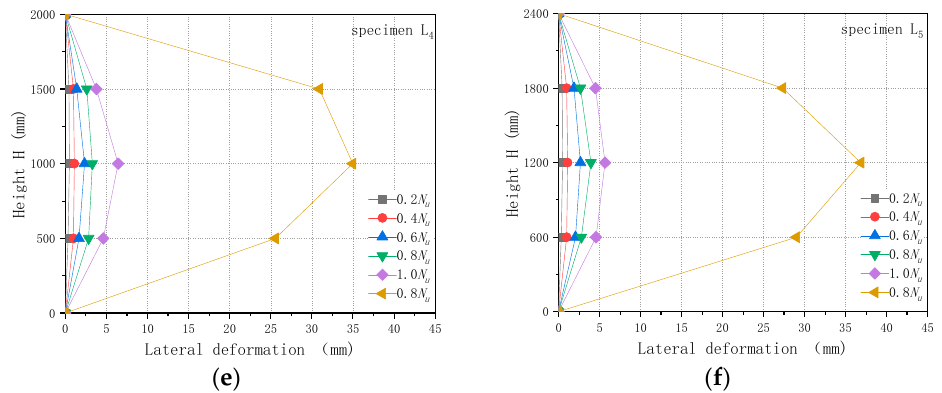
Figure 4. Peak load-slender ratio relationship for CFGT composite columns: ( a ) L0; ( b )L1; ( c ) L2; ( d ) L3; ( e ) L4; ( f ) L5.